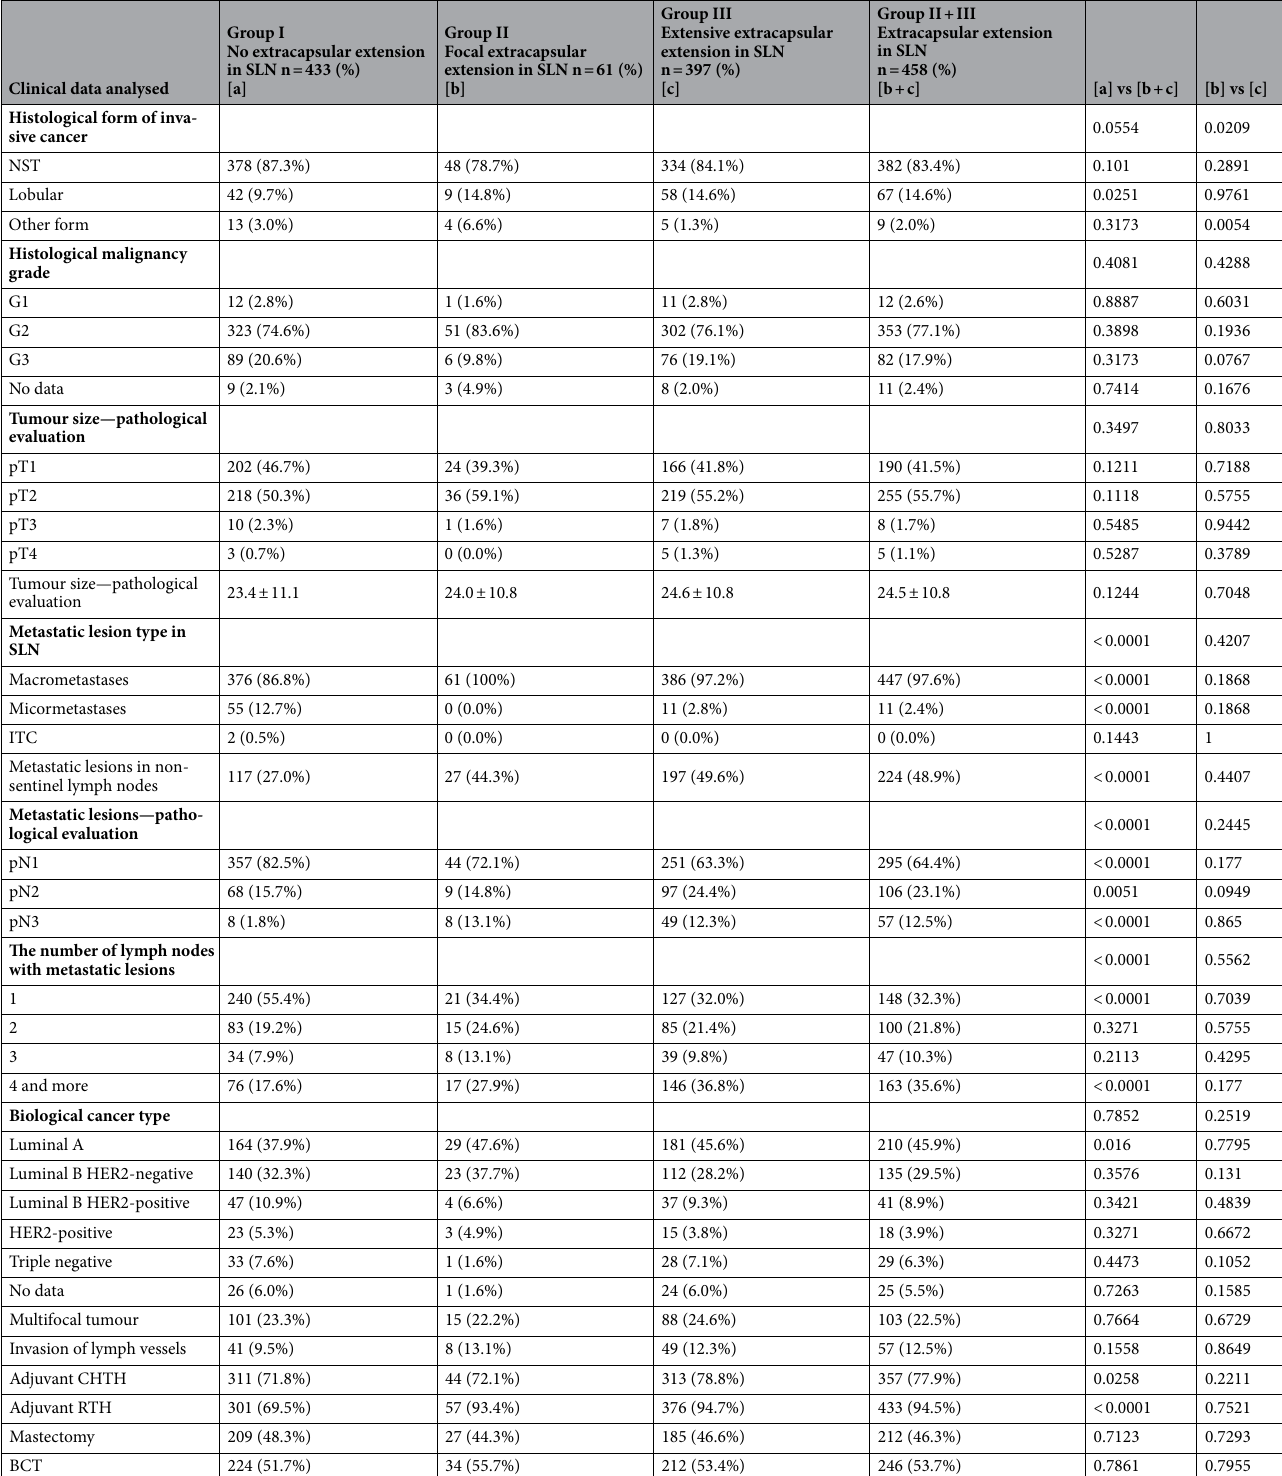
Table 1. Clinical characteristics of patients qualified for the study—univariate